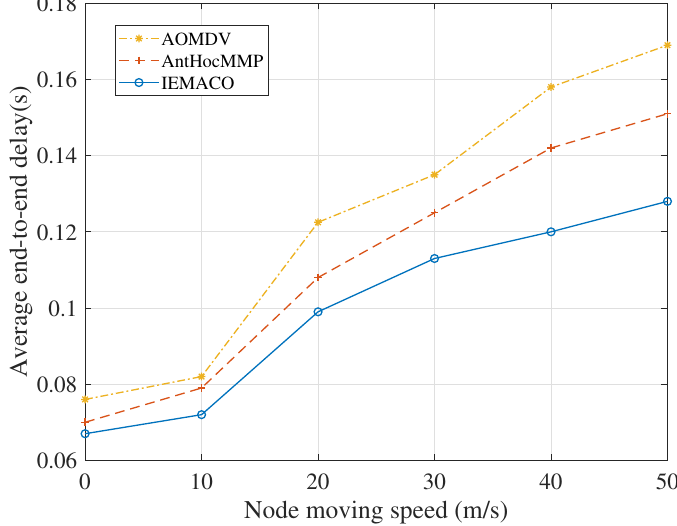
Figure 4. Average end-to-end delay versus node moving speed.